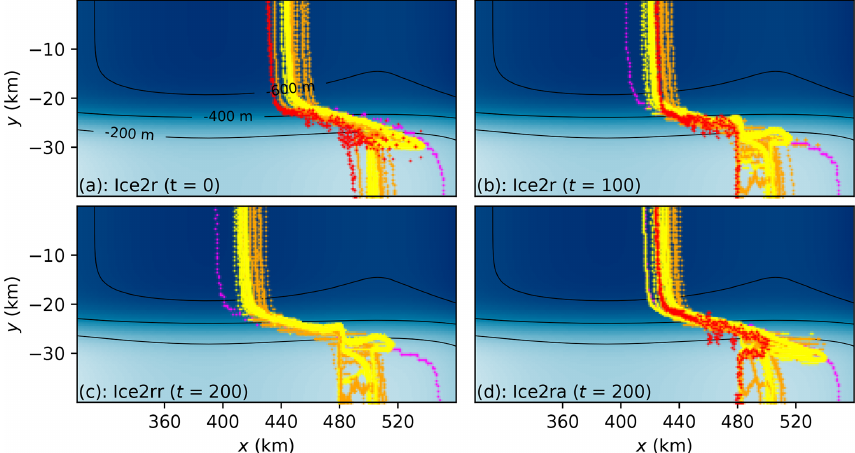
Figure 12. Grounding line migration for all models with (cid:49)x ≤ 1km in the Ice2 experiments. The Ice2r experiment starts (as does the Ice1r experiment; see Fig. 4) from the Ice0 steady-state position at t = 0 a (a) . Grounding lines migrate upstream while the melt rate of Eq. (8) is applied until t = 100a (b) . There are two branches for t > 100a: the Ice2rr branch which continues with the same melt rate (c) and the Ice2ra branch with zero melt rate (d) . Yellow contours correspond to SSA, L1Lx, and HO models with the Coulomb-limited basal friction laws; orange contours to SSA, L1Lx, and HO models with the Weertman basal friction laws; red contours to the full-Stokes model (ISSM only); and magenta contours to HySSA models. The color map and black contours depict bedrock